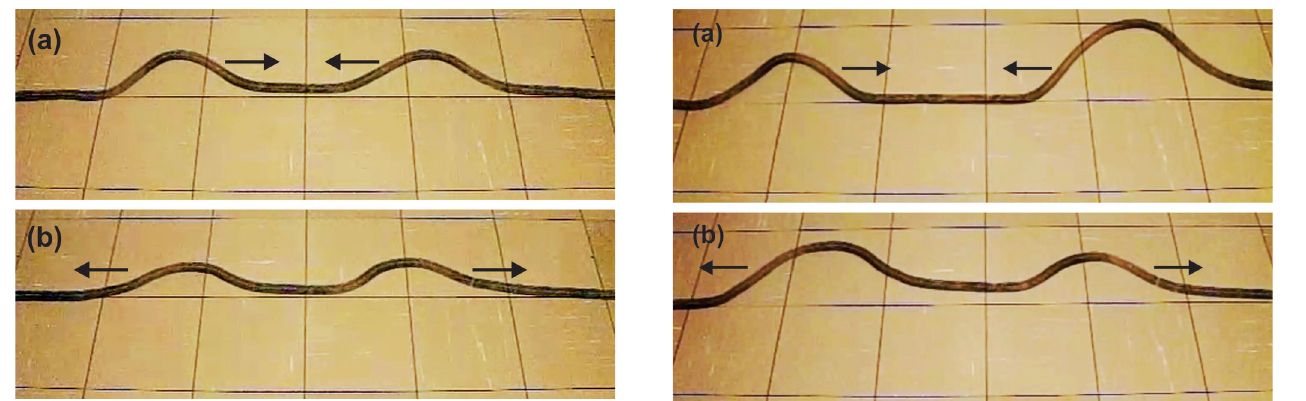
FIG. 2. Outcome of the first testing experiment. Snapshots of the two pulses (a) before and (b) after they meet.